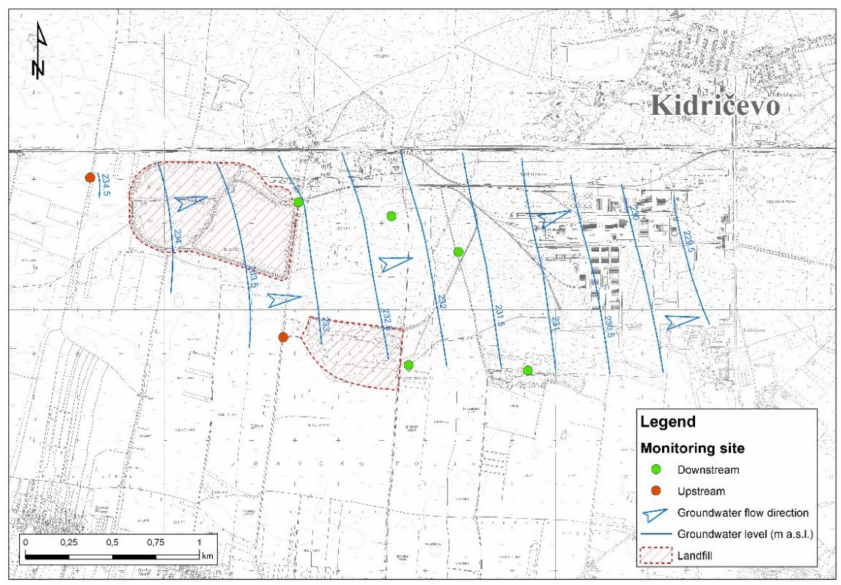
Figure 2. Example of the monitoring site positions at landfill. The sampling set on karst aquifers consisted mostly of springs and to a lesser extent boreholes. The distances between monitoring points were in most cases greater than 10